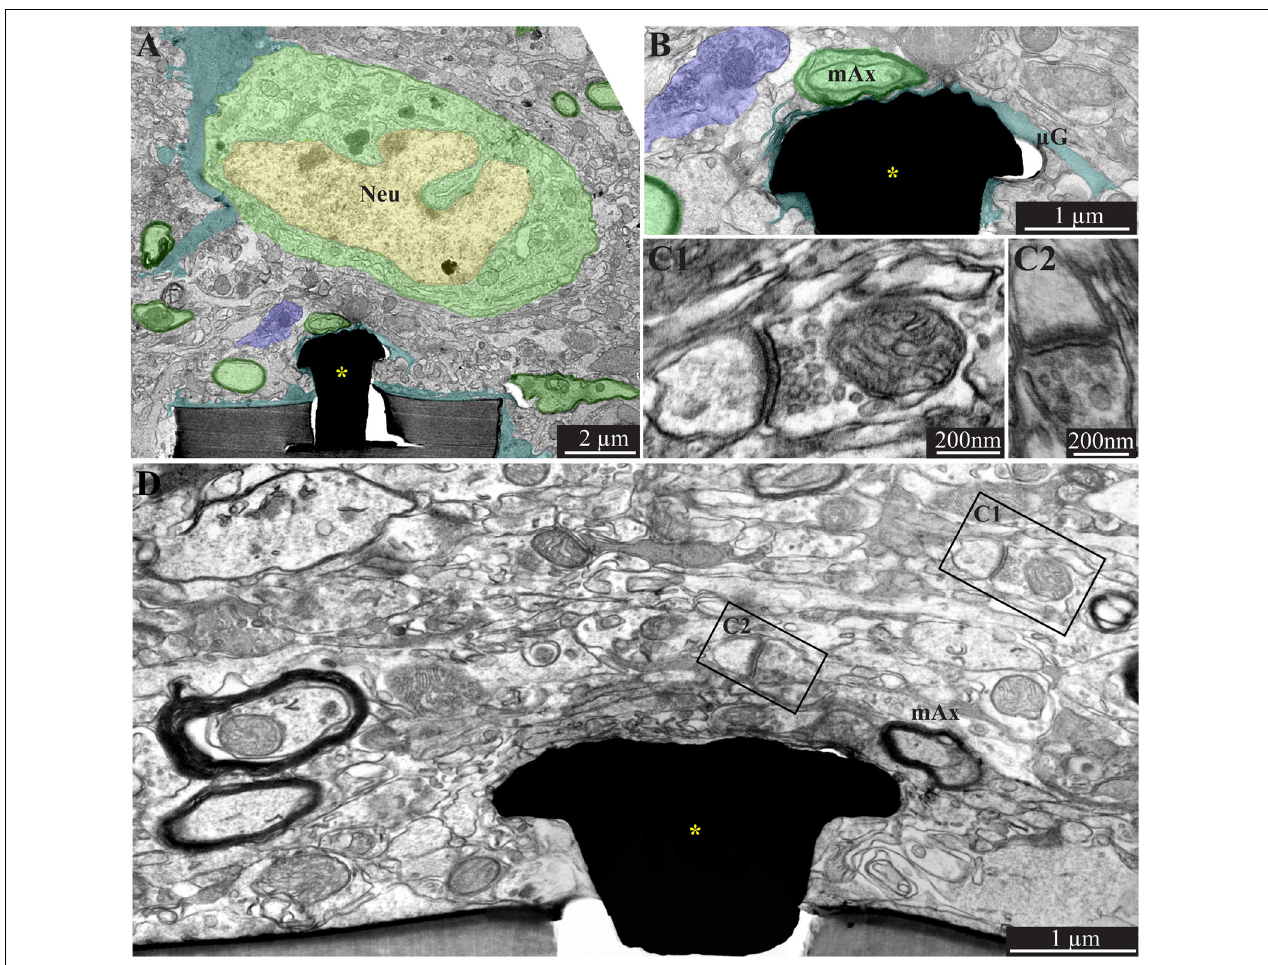
FIGURE 7 | A low (A) and high magnification (B) , transmission electron microscope image of the interfaces formed between a gold mushroom shaped microelectrode extending from a polyimide platform implanted for 8 weeks and the surrounding cortical tissue. As the regenerative processes of the brain parenchyma proceed with time, the dark microglia adhering layer becomes thinner ( A,B , cyan). It is conceivable that even a thin microglia layer might insulate the electrodes from the surrounding parenchyma. (D) The regenerative processes of the parenchyma are also evidenced by the presence of a chemical synaptic profile as close as a few micrometers from the implant ( C1,C2 , see D for the location of the synapses with respect to the electrode). Note that the TEM section (in D ) is slightly tilted in respect to the long axis of the gM µ E. For that reason the base of the mushrooms stalk appears to taper toward the polyimide platform. Interestingly, 8 weeks after implantation we also observed gM µ E that were not enwrapped by microglia and formed a direct contact with the small profile of astrocyte and possibly neurons (D) . gM µ E, yellow asterisks; Neu, neuron; mAx, myelinated axons; µ G, microglia. An unmarked copy of this figure is presented as Supplementary Figure 8